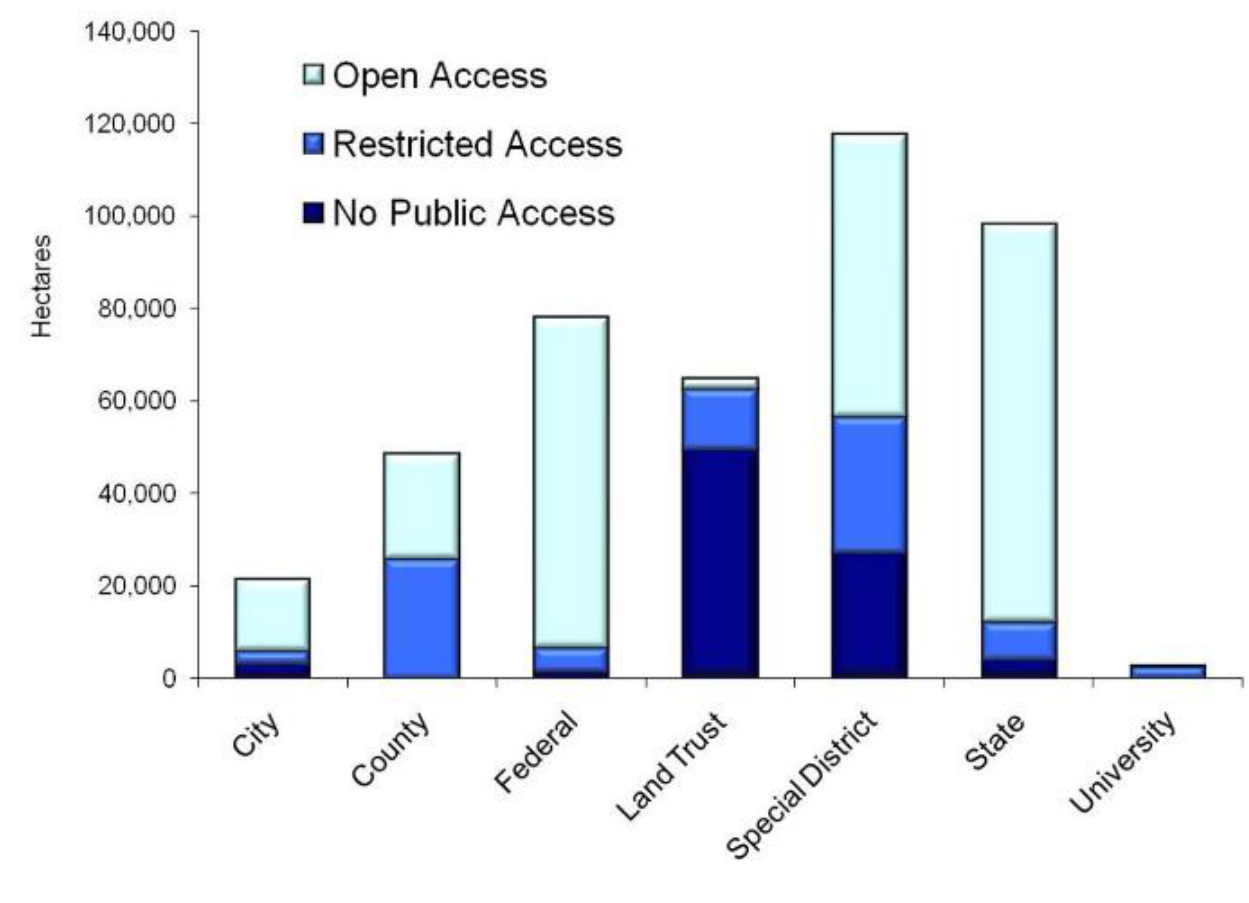
Fig. 8 . Recreational access to San Francisco Bay Area protected lands by